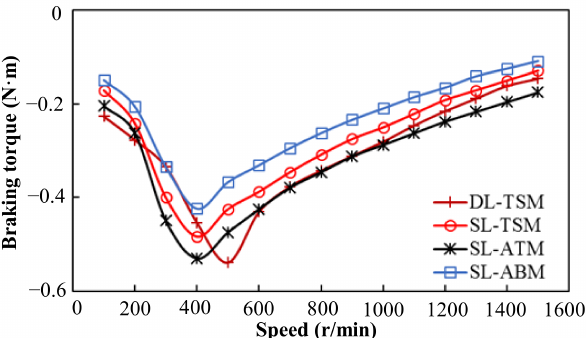
Figure 11. Variation of the braking torque with speed under single-phase short circuit condition.